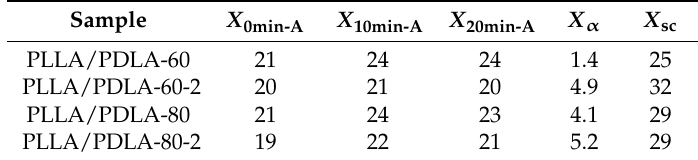
Table 2. The phase contents of PLLA/PDLA fibers during annealing at 200 °C and cooling to room temperature.